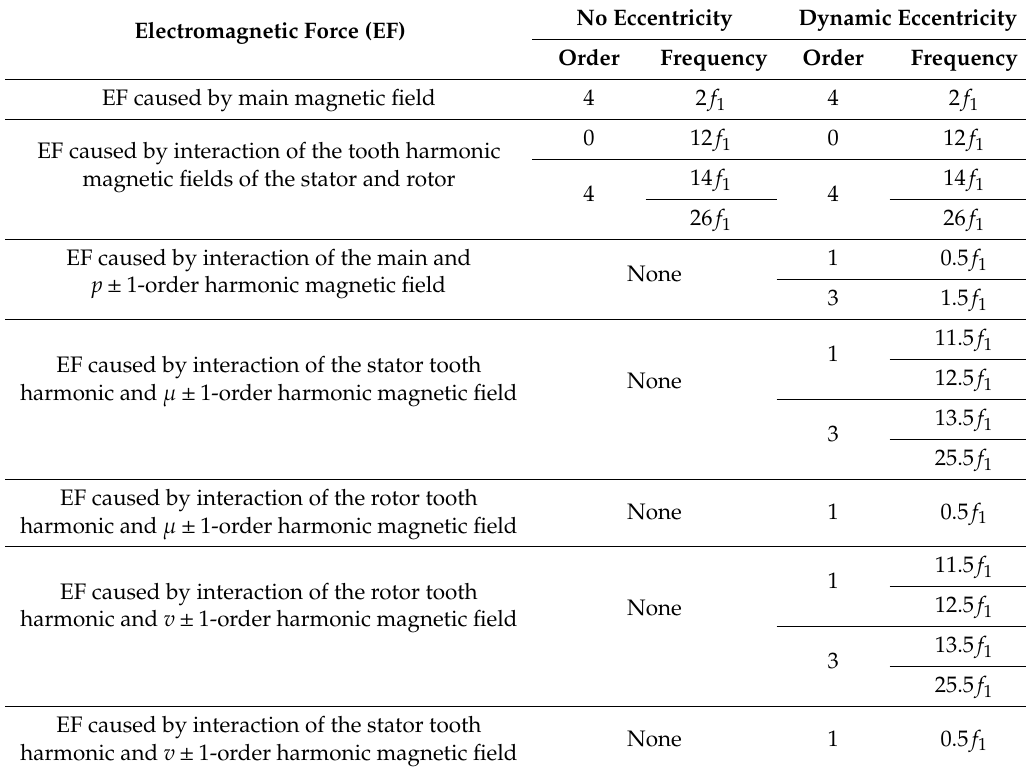
Table 1. Electromagnetic forces of ZYS-170MD12Y16 motorized spindle under no eccentricity and dynamic air gap